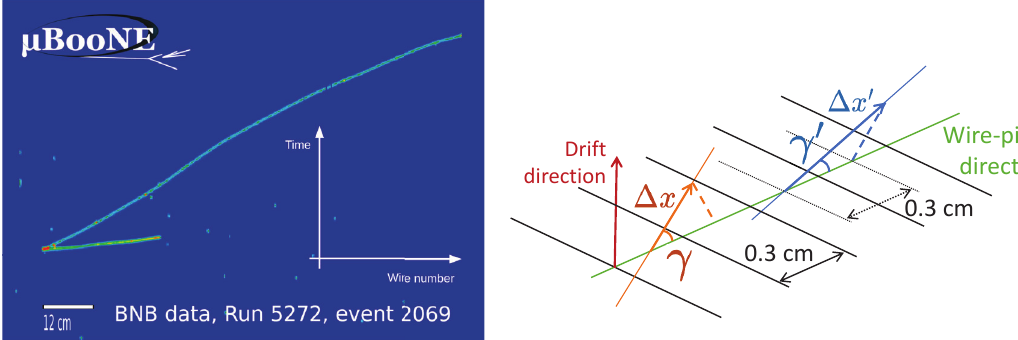
CC interaction in MicroBooNE with two tracks in Figure 1. Left: example of a raw image of a ν μ the final state, as recorded on the collection plane. The deposited charge (color scale) is shown as a function of wire number (x-axis) and time (y-axis). The ionization profiles of the two particles are used to identify them as one proton and one muon. Right: a sketch of the relevant directions and angle in the calorimetric reconstruction. The orange and blue arrows represent two possible particle trajectories with different gamma angles and different local pitch values, represented by their lengths. Black solid lines represent wires, spaced 0.3 cm apart. The dashed lines are perpen- dicular to the wire-pitch direction, and make evident the connection between the angle γ and Δ x , through eq.